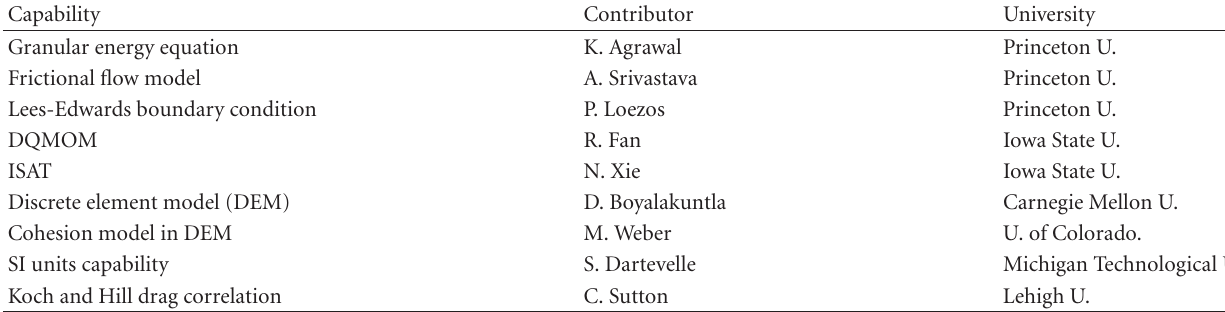
Table 3: Major capabilities added to MFIX by graduate students.